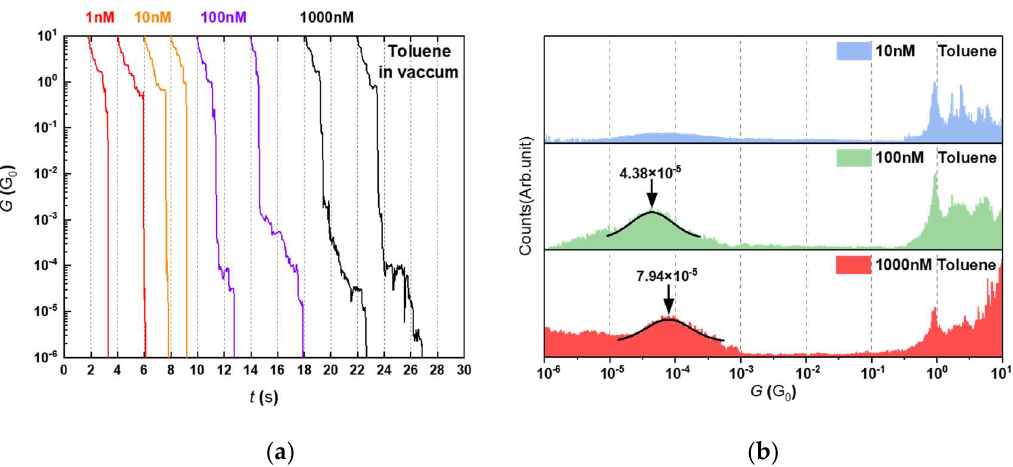
Figure 6. ( a ) Typical conductance traces and ( b ) corresponding histograms in vacuum with ODT dissolved in toluene at various concentration conditions from 1 nM to 1 μM.